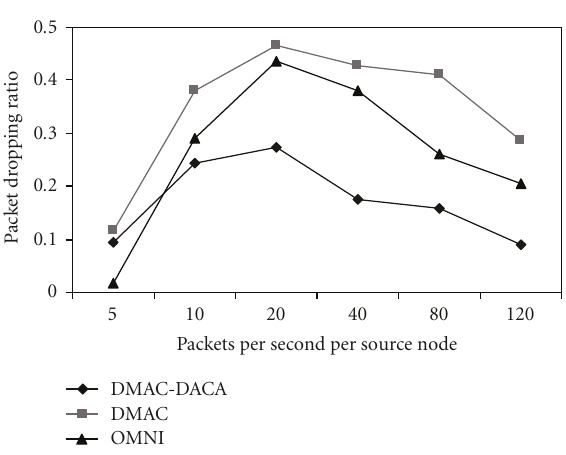
Figure 16: E ff ect of DMAC-DACA’s DA mechanism.